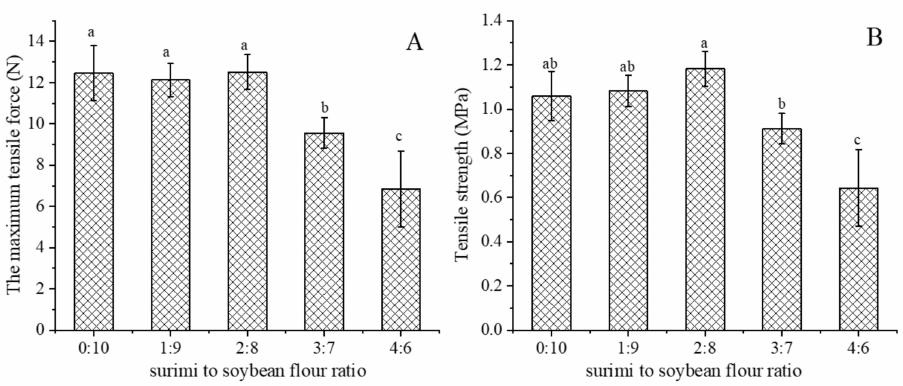
Figure 3. The maximum tensile force ( A ) and tensile strength ( B ) of extrudates with different surimi to soybean flour ratio. Different letters mean significant differences ( p < 0.05).